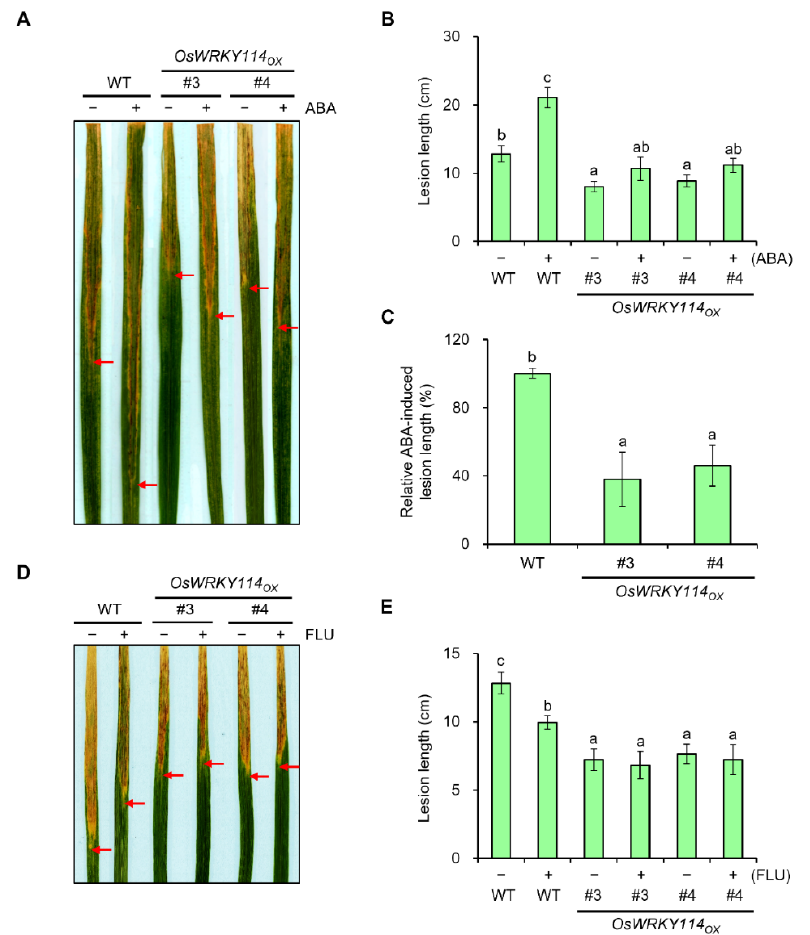
Figure 3. Overexpression of OsWRKY114 suppresses ABA-induced susceptibility to Xanthomonas oryzae pv. oryzae . ( A – C ) Bacterial blight disease of ABA- or mock-treated rice plants. Four-week-old rice plants were pretreated with 100 µM ABA or mock solution. Three days later, leaves were inoculated with Xoo . ( A ) Representative images of lesions captured 14 days after inoculation. ( B ) Lesion length across genotypes and treatments. ( C ) ABA-induced lesion length across genotypes according to the following equation: ABA-induced lesion length (%) = ([Lesion length of ABA-pretreated plants] − [Lesion length of mock-pretreated plants]) × 100. The red arrow indicates the end of the lesion length. Data are shown as means ± SD. Different letters indicate statistical differences according to ANOVA ( p < 0.05). ( D , E ) Bacterial blight disease of FLU- or mock-treated rice plants. Four-week-old rice plants were pretreated with 10 µM FLU or mock solution. Three days later, leaves were inoculated with Xoo . ( D ) Representative images of lesions were captured 14 days after inoculation. (E) Lesion length across genotypes and treatments. The red arrow indicates the end of the lesion length. Data are shown as means ± SD. Different letters indicate statistical differences according to ANOVA ( p < 0.05).